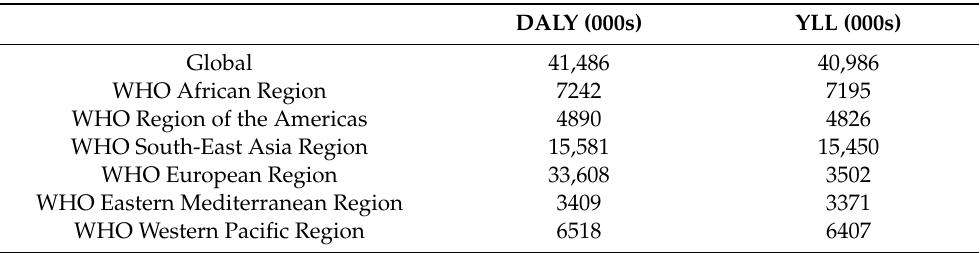
Table 2. Disease-related disability-adjusted life years (DALY) and of years of life lost (YLL) due to liver-related diseases according to the WHO. By region, collected during the years 2000–2015 [5].